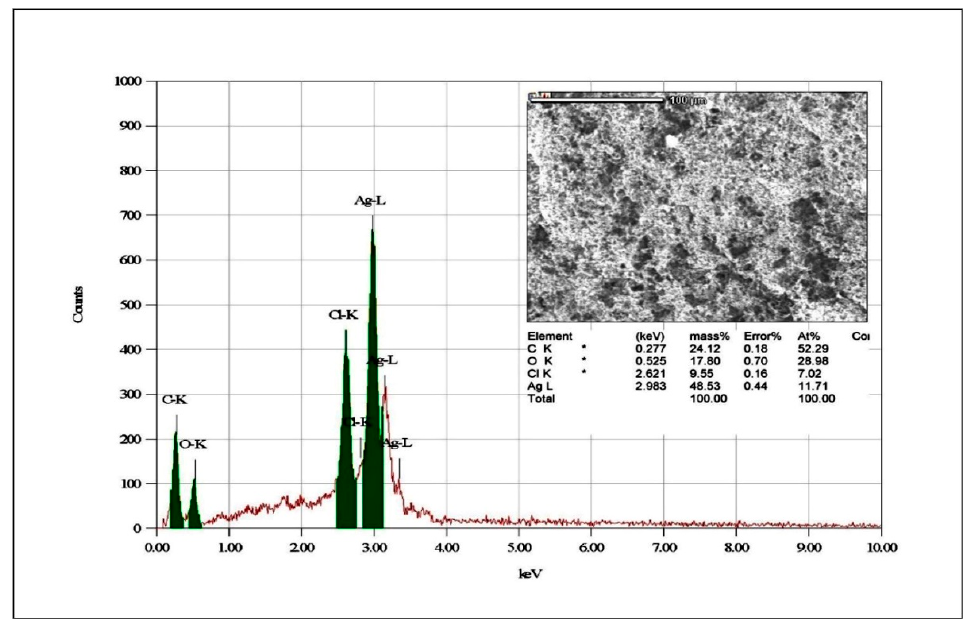
Figure 6: EADX spectrum observed elemental distribution Ag–L, C–K, O–K and Cl–K from syn- thesized UD-AgNPs.